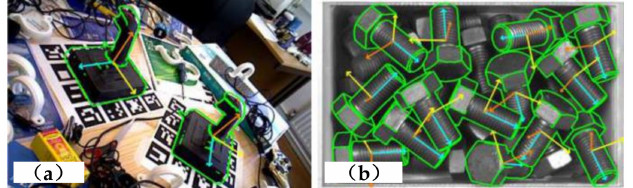
Figure 4. Scenarios of objects’ 6D pose estimation [40]: ( a ) tabletop scenario, ( b ) bin-picking